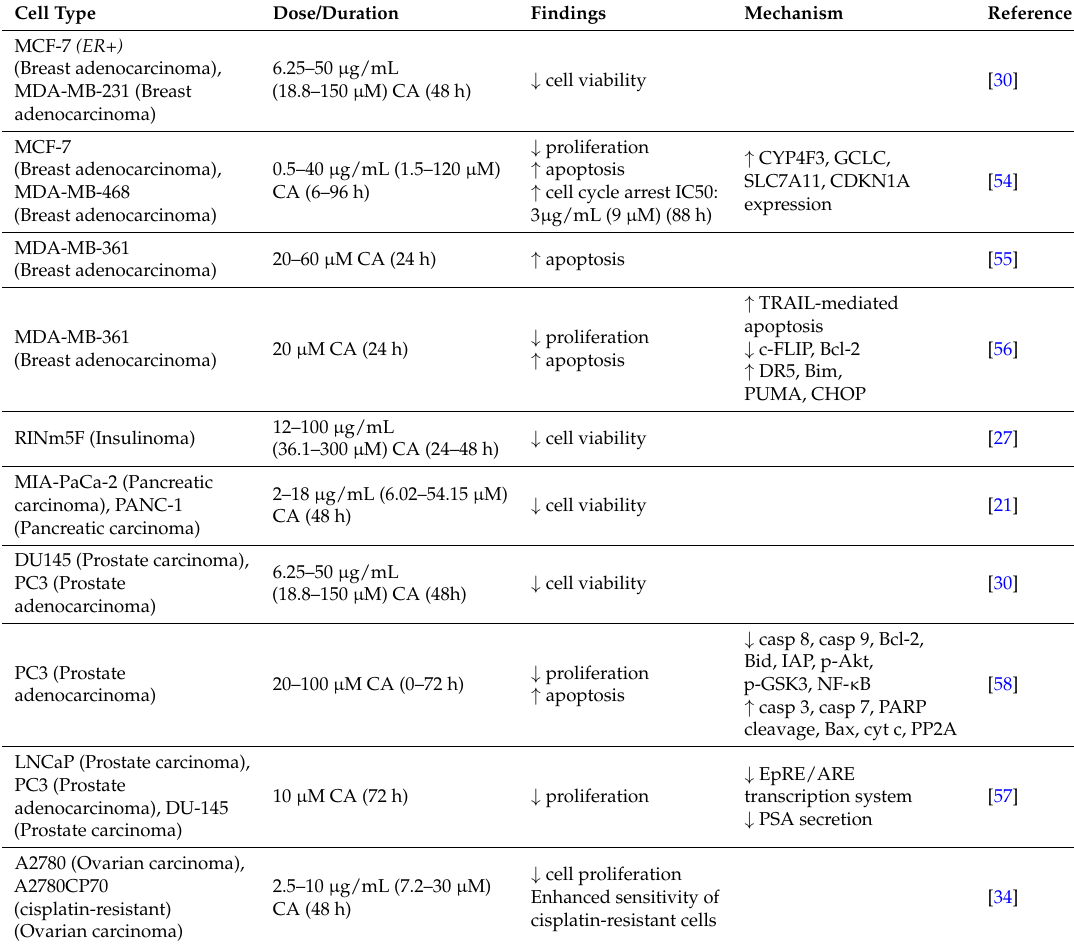
Table 8. Anticancer effects of Carnosic Acid (CA). In vitro studies: breast, pancreatic, prostate and ovarian